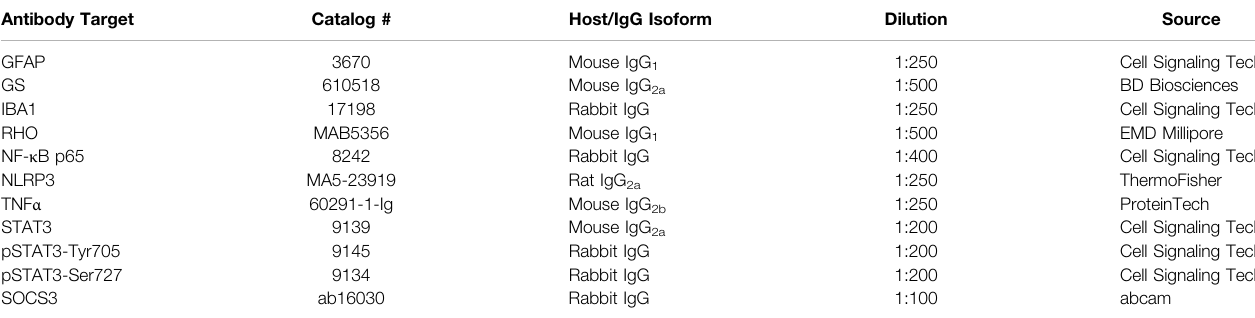
TABLE 1 | Antibodies used for IHC labeling of retinal sections. Antibody